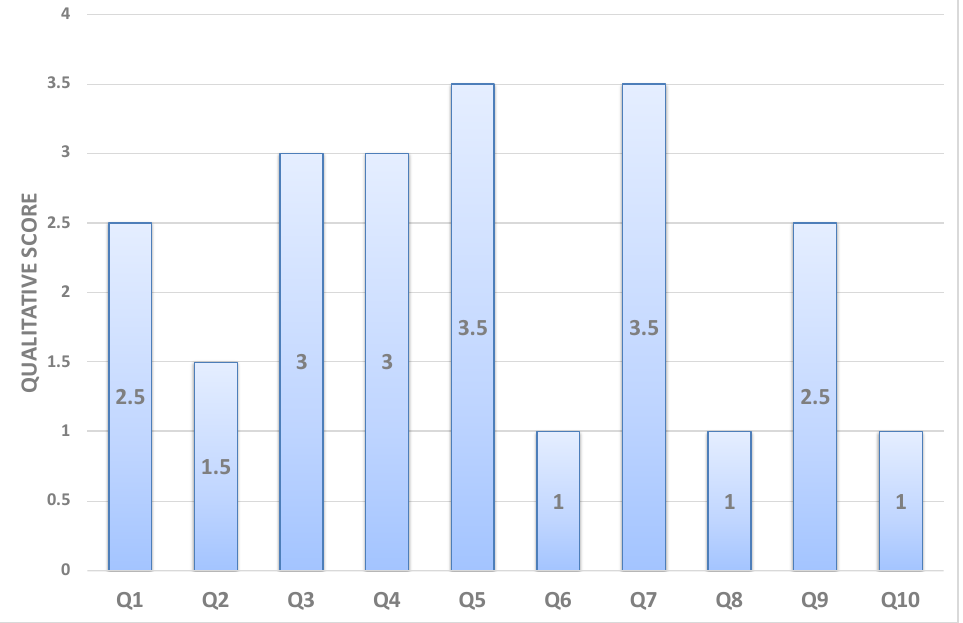
Figure 21. Average of patient feedback on